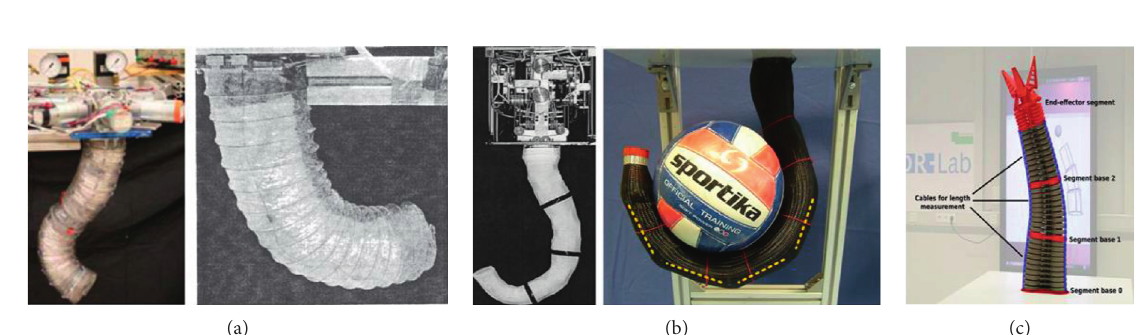
Figure 2: Single-segmented [14, 16] (a), multisegmented [19, 28] (b), and continuum robots [29] (c)—elephant trunk